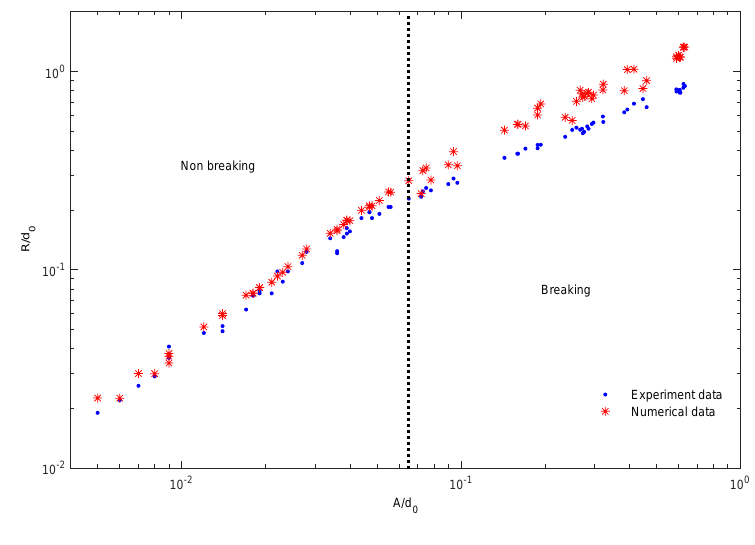
Figure 9. Run-up solitary wave with various wave